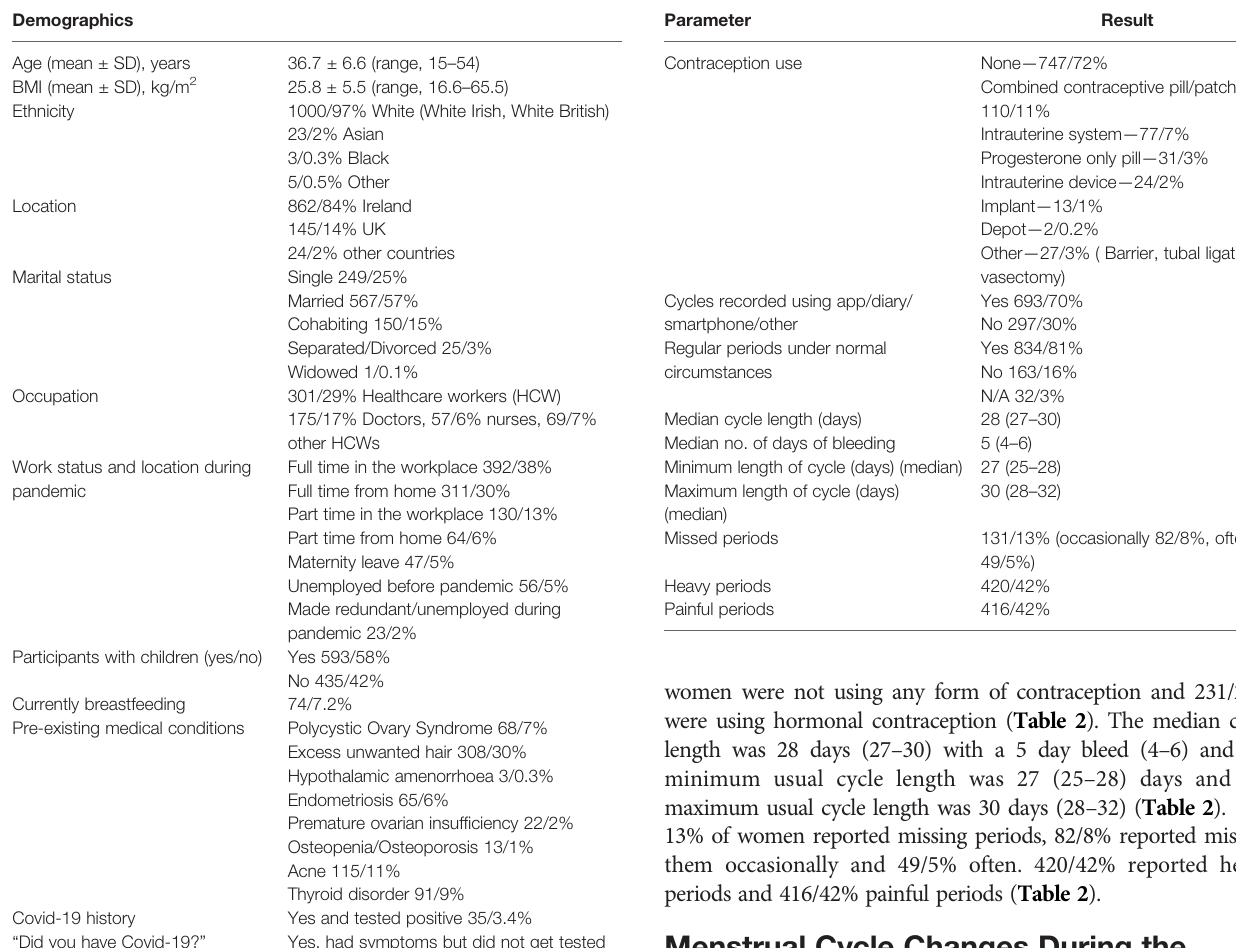
TABLE 2 | Menstrual history and contraceptive use. TABLE 1 | Participant demographics/medical